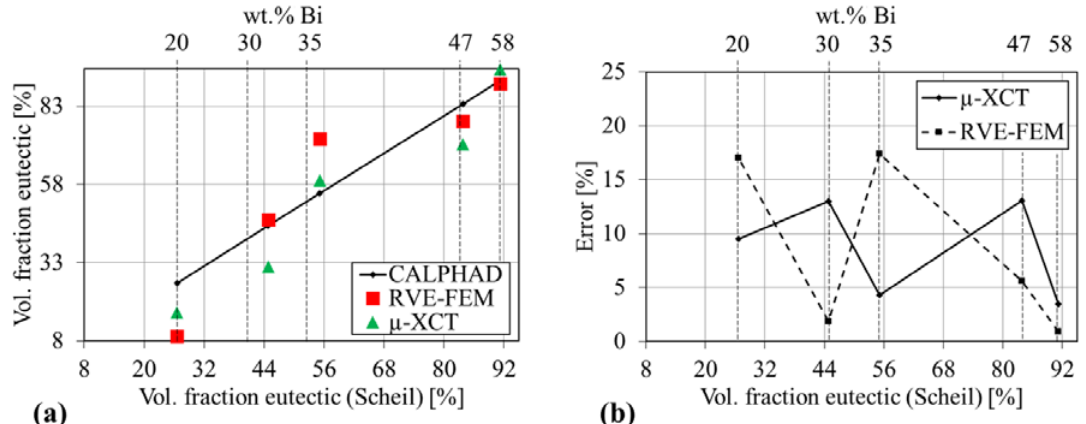
Figure A2. Eutectic volume fraction from CALPHAD calculations, µ -XCT imaging and the RVE-FE model ( a ) eutectic volume fraction over composition ( b ) relative error of µ -XCT data and RVE-FE model based on Scheil CALPHAD calculations over composition.